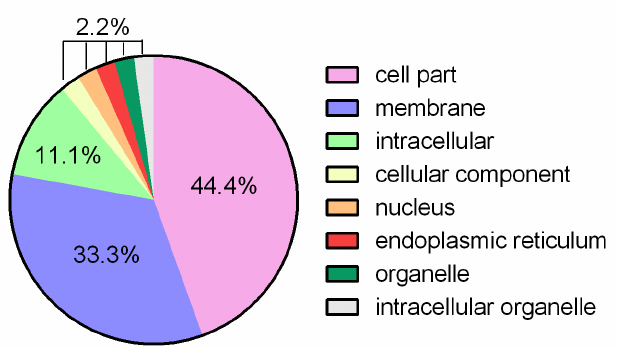
Figure 6. Cell components related to proteins belonging to the shared clusters of L. fermentum strains ATCC 23271, 2760, 3872, CECT 5716, AGR 1485 and DR 9.